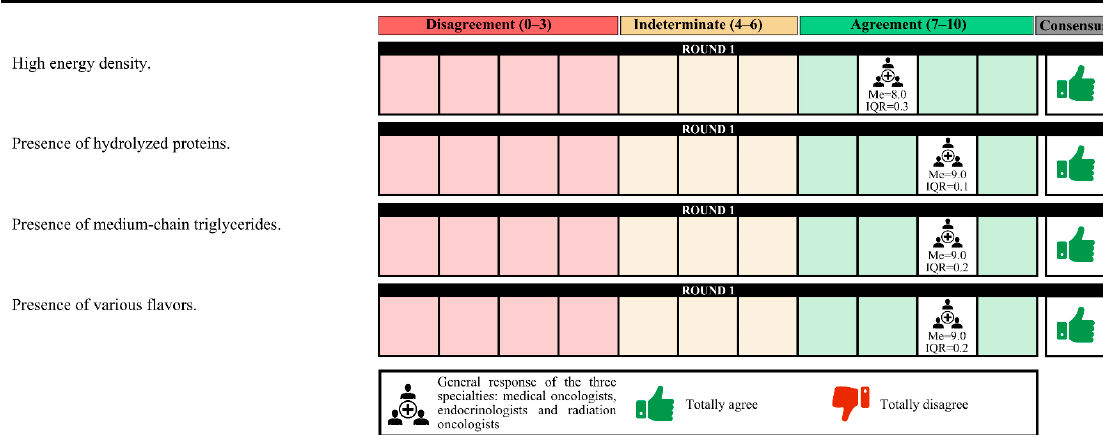
Figure 8. Answers about nutritional therapy (IV). IQR, interquartile range; Me, median.